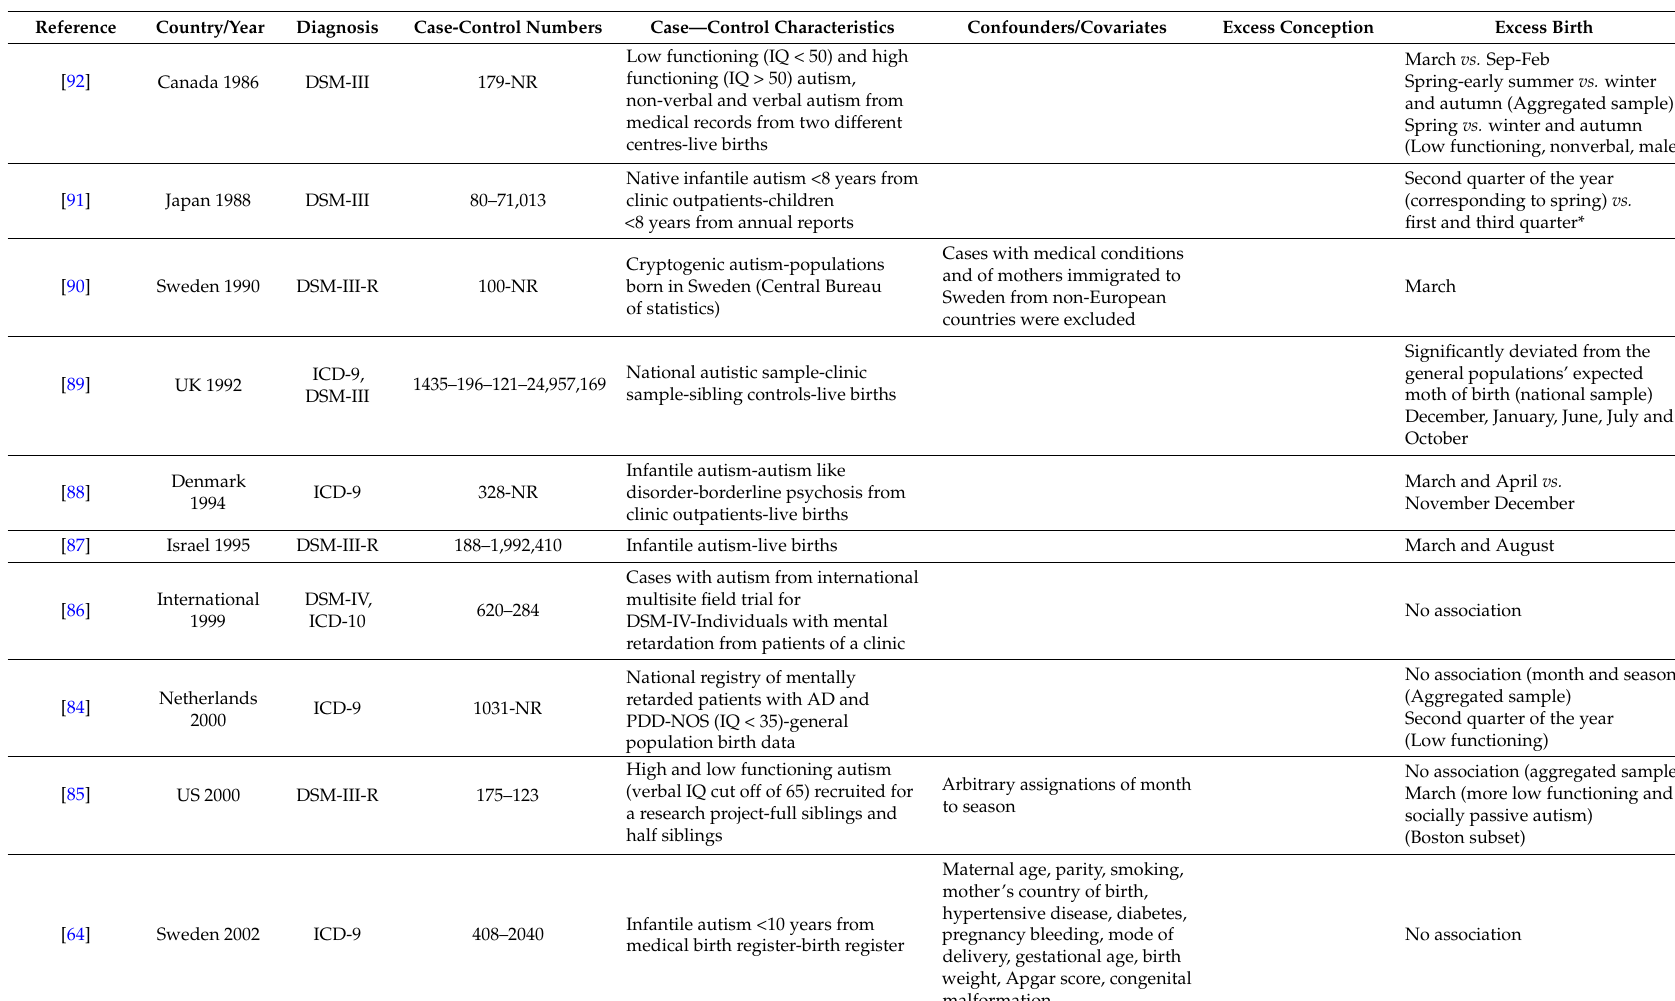
Table 3. Risk of autism according to seasonality of conception and